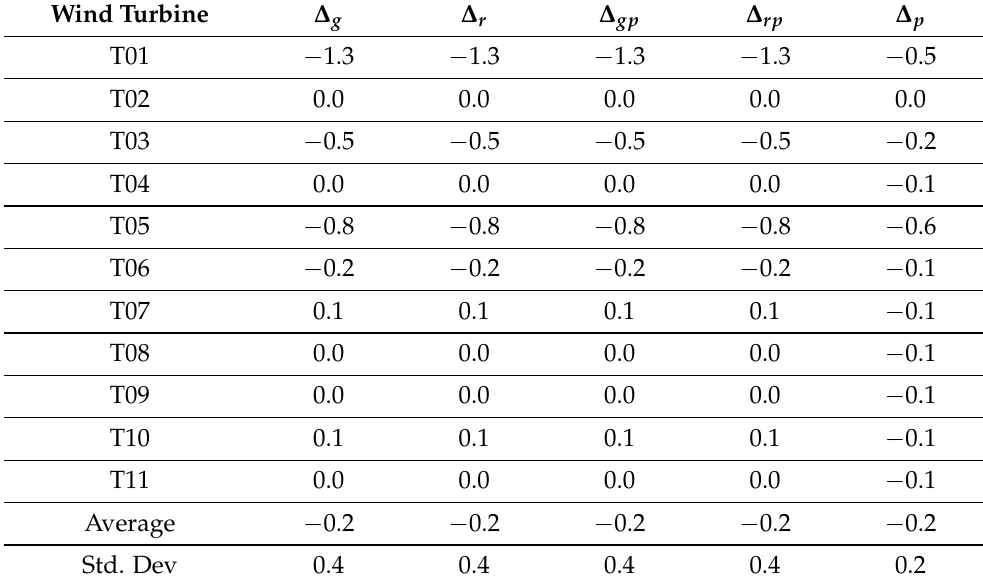
Table 7. Estimates of the average percentage energy yield decline with age for the considered working region and operation curves: WF2. ∆ g and ∆ gp (respectively, ∆ r and ∆ rp ) quantify the average percentage energy yield change due to the decrease in extracted power for given generator (respectively, rotor) speed in Region 2; ∆ p quantifies the same quantity as a function of the blade pitch in Region 2 1 / 2 . The metrics are computed according to Equation